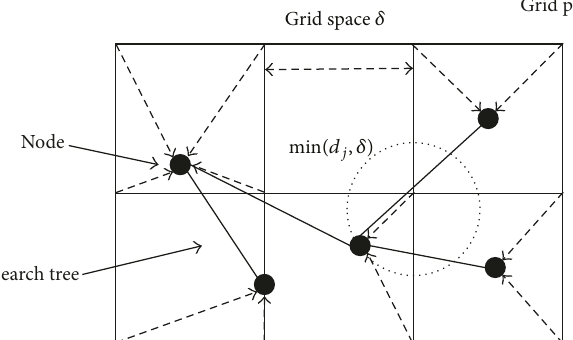
Figure 1: Grid point distance from the nearest node in the tree. 𝛿 is an adjustable grid spacing, and the dashed arrow indicates the distance, 𝑑 𝑗 , from the grid points to their closet nodes in tree.